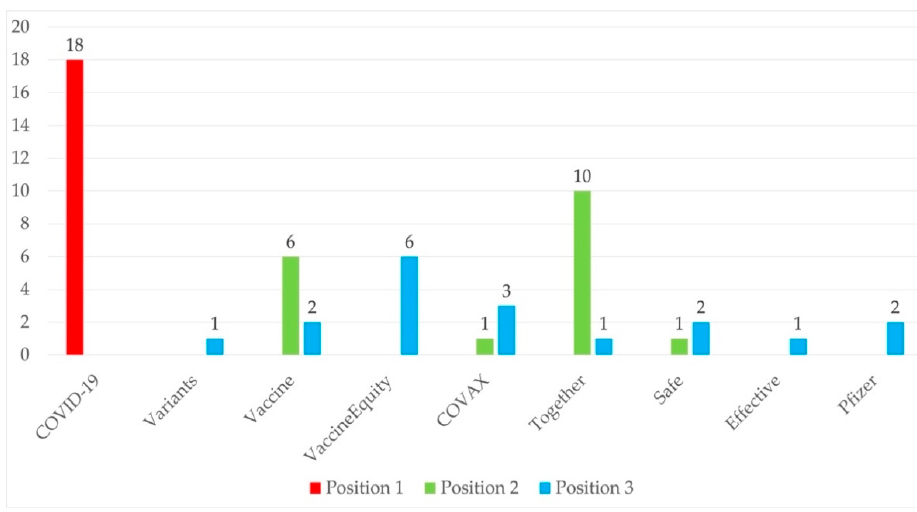
Figure 4. Evolution of the nature of the messages.